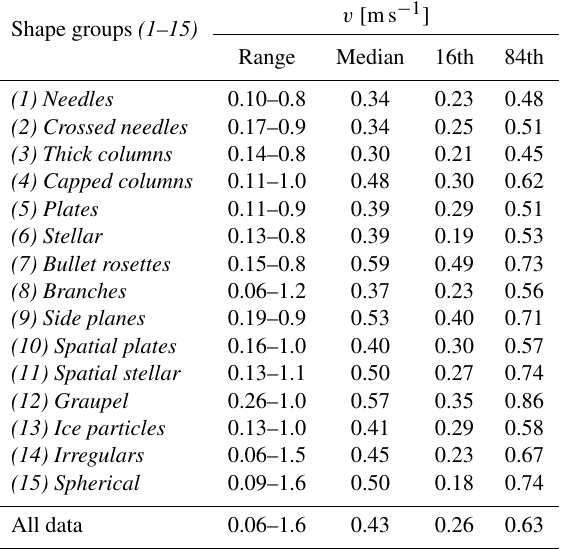
Table 2. Fall speed, v , for the shape groups. The fall speed range, median, and 16th and 84th percentiles are displayed. For compari- son, results for all the data, regardless of shape, are also